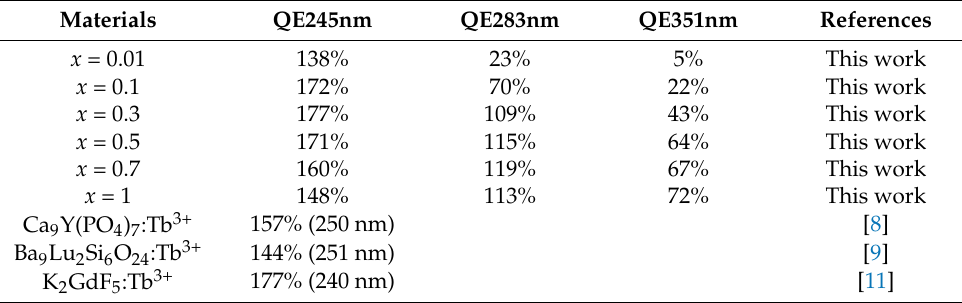
Table 1. Quantum efficiency of KYC: x Tb 3+ excited at different